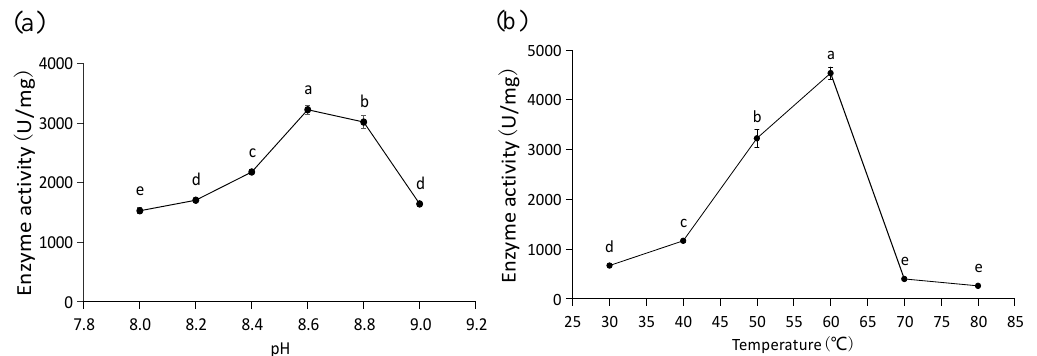
Figure 6. Functional characterization of recombinant PaPAL. ( a ) Optimal pH analysis of recombinant PaPAL; ( b ) optimal temperature analysis of recombinant PaPAL. The data represent the mean values of three replicates ± standard errors (SEs). The different letters (a, b, c, d and e) on the SE line represent statistically significant differences at p ≤ 0.05 (Duncan´s multiple range test).